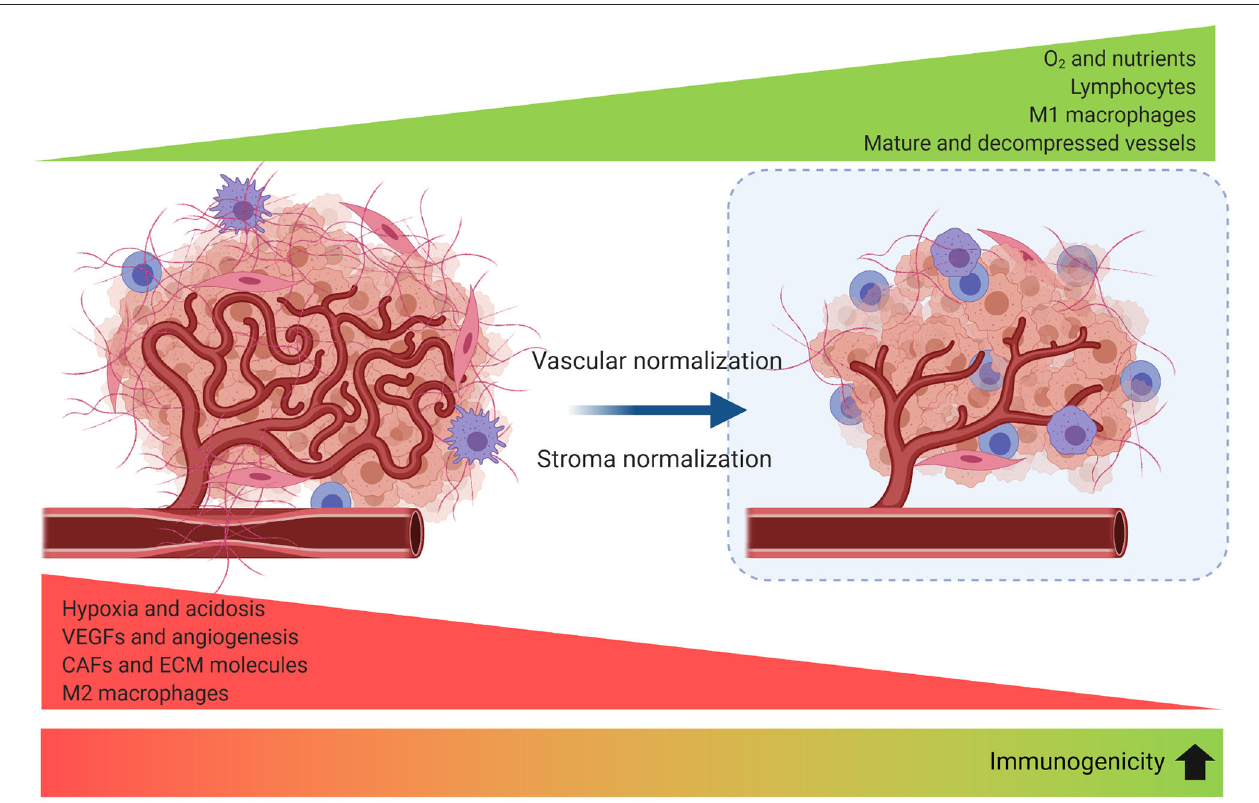
FIGURE 5 | Strategies to improve tumor perfusion increase tumor immunogenicity. Angiogenesis, desmoplasia, and inflammation promote leaky and compressed tumor vessels. Vascular normalization strengthens the vessel wall reducing intercellular gaps and improving perfusion. Blood vessel decompression by depletion of CAFs or ECM reperfuses the vessel and augments perfusion. As a result, reprogramming of the TME to an immunomodulatory state enhances antitumor immunity.